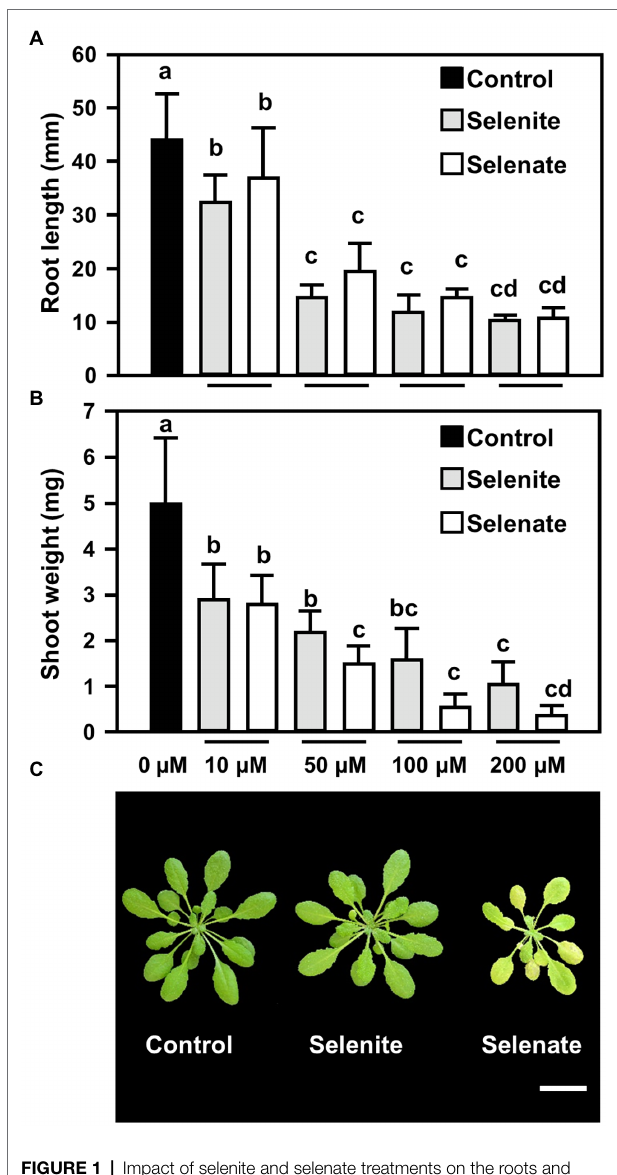
FIGURE 1 | Impact of selenite and selenate treatments on the roots and leaves of Arabidopsis plants (A,B) Impact of increasing concentrations of selenite and selenate (0–200 μ M) on root length (A) and shoots fresh weight (B) of Arabidopsis . Six-days-old seedlings were challenged for additional 15 days on At-medium (Control, black bars) or At-medium containing either selenite (gray bars) or selenate (white bars). Different lowercase letters indicate individual groups identified by pairwise multiple comparisons with a Holm- Sidak one-way ANOVA ( p = 0.05, n = 7). (C) Top view of six-week-old hydroponically grown Arabidopsis plants that were either challenged for seven days with ½ Hoagland media supplemented with selenite (50 μ M Na 2 SeO 3 ) or selenate (50 μ M Na 2 SeO 4 ). The control plants were grown under the same conditions (100 μ E light for 8 h, 50% humidity and 22 ° C day/18 ° C night) on ½ Hoagland medium lacking selenium. Images were digitally extracted for comparison. Scale bar = 1 cm. FW, fresh